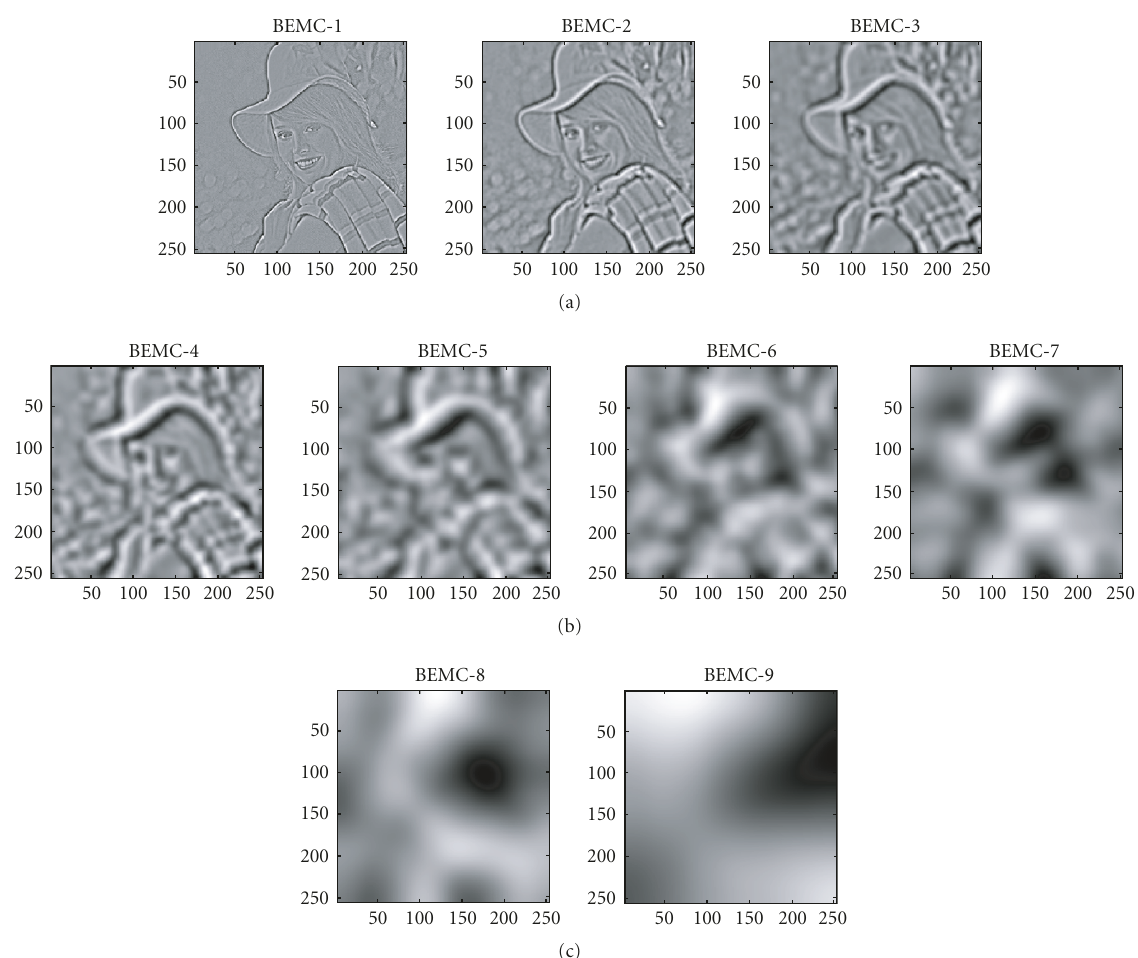
Figure 21: BEMCs of Elaine image obtained by FABEMD with Type-1 OSFW (MNAI =